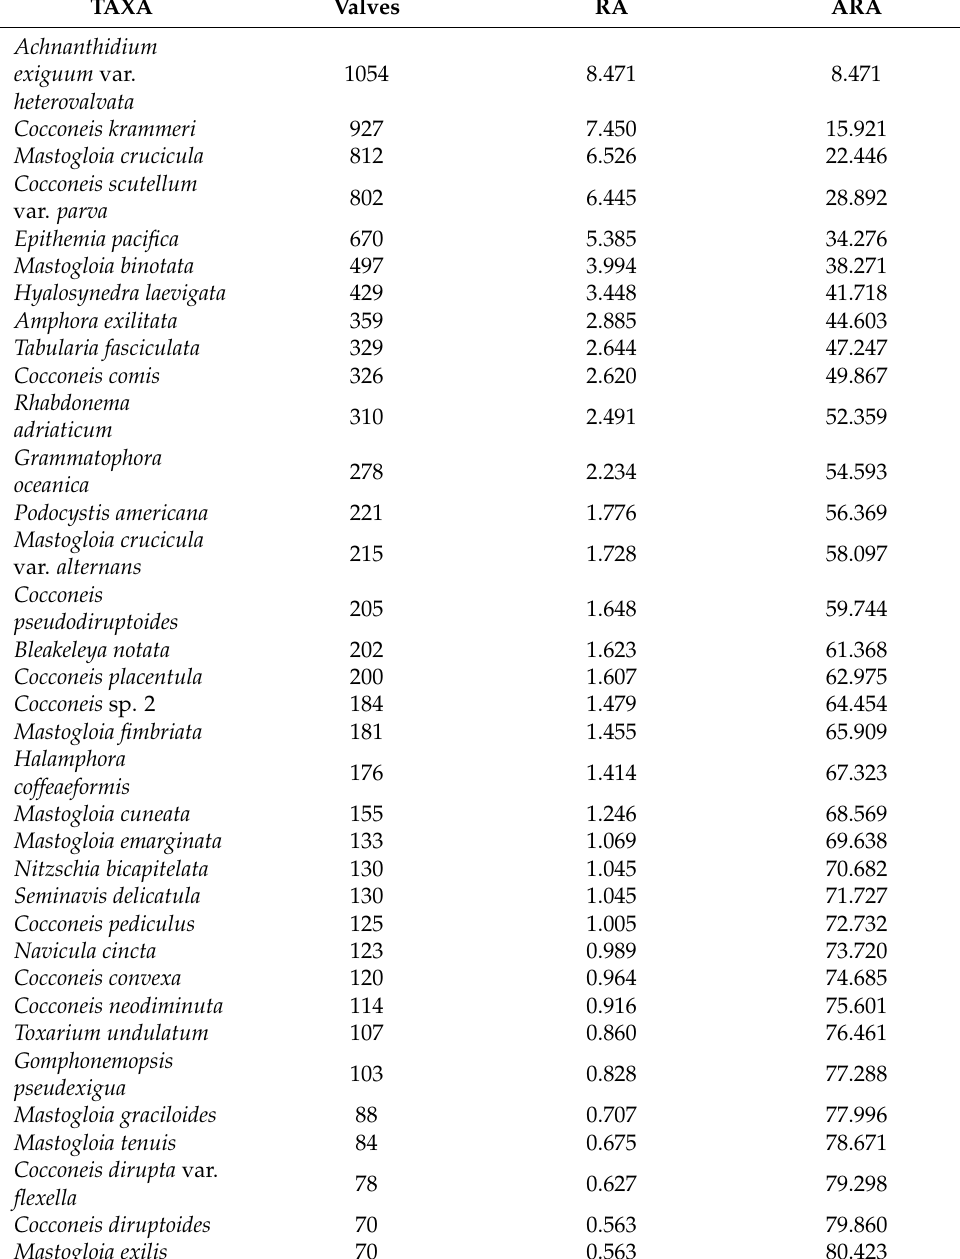
Table 2. Estimated relative abundances (RA) for the benthic marine diatom taxa found on macroalgae hosts from the Revillagigedo Archipelago, Mexico (N = 12,443). Taxa comprising 80% of the total valves counted. ARA = accumulative relative